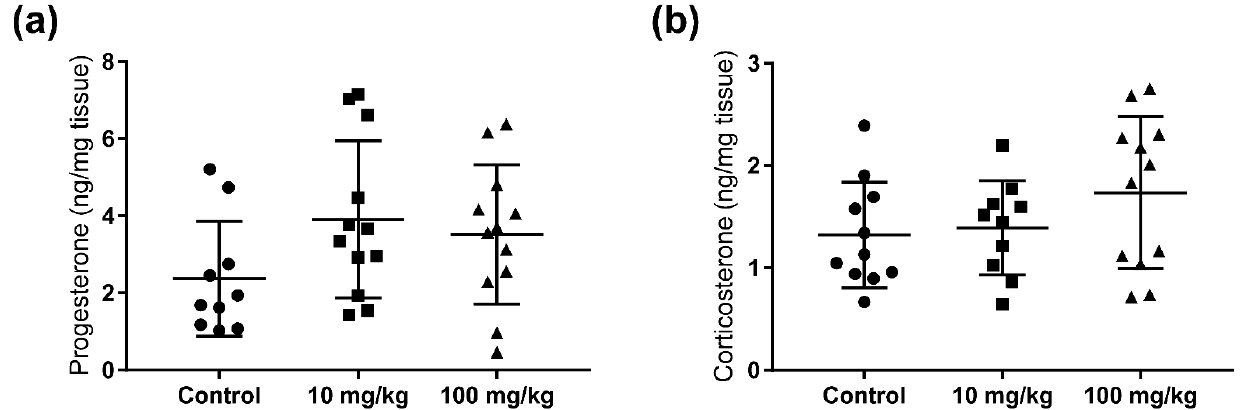
Figure 2. Persistent effects of five weeks oral DBP exposure on adrenal gland steroid hormone production in adult mice. Levels of corticosterone ( a ) and progesterone ( b ) were measured by LC-HRMS in mouse adrenal glands collected one week after the last DBP administration. Values represent mean ± S.D. from 12 animals per group. The statistical analysis revealed no significant group differences (Kruskal–Wallis followed by Dunn’s test).